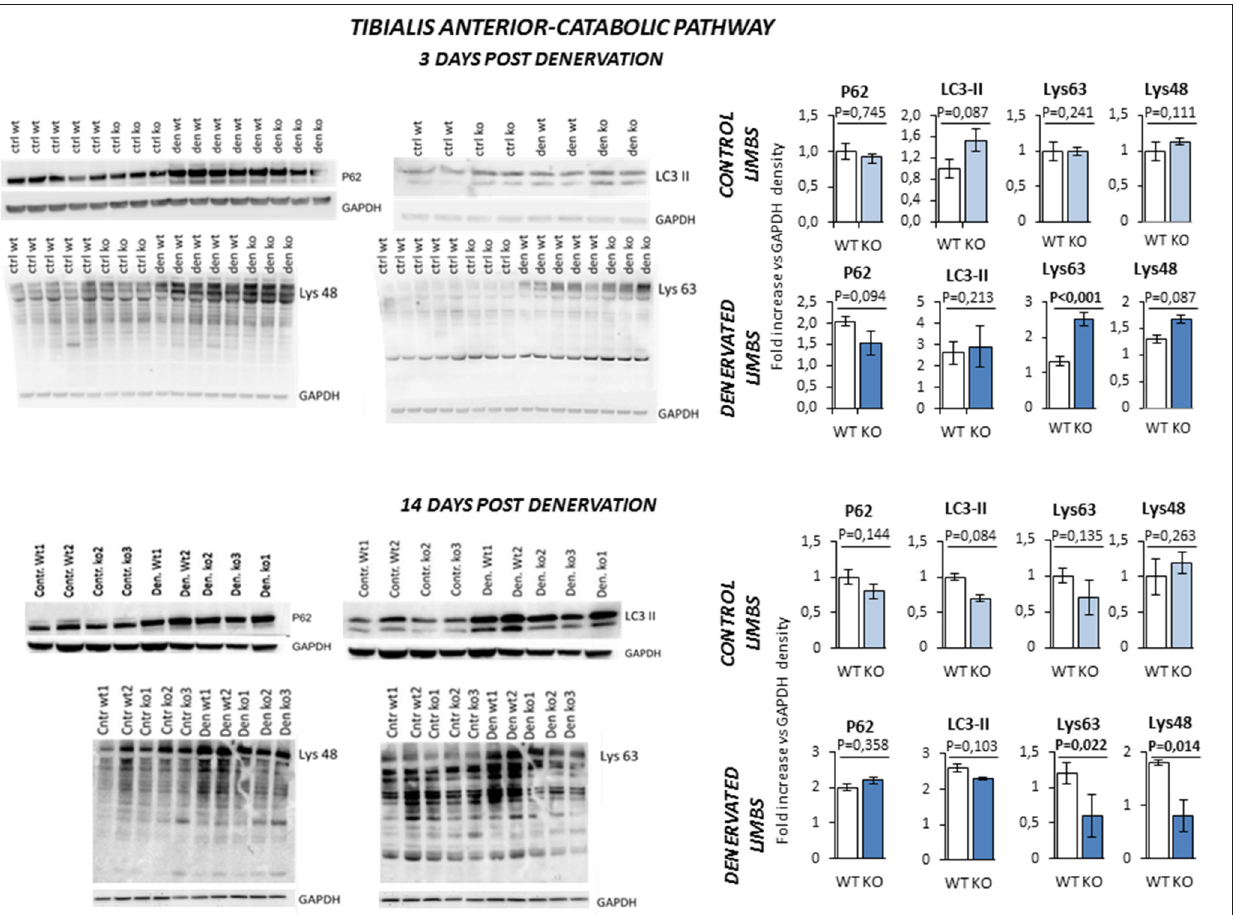
FIGURE 8 | Activation of catabolic pathway in tibialis anterior muscle specimens obtained from contralateral non-denervated (CONTROL) and denervated (DENERVATED) limbs in wild type (WT) and Rxfp2 − / − mice (KO), at both 3 (WT, N = 5; KO, N = 4) and 14 (WT, N = 6; KO, N = 5) days post-denervation. LC3-II and P62, markers of cell autophagy, and Lys-48 and Lys-63 poly-ubiquitination (poly-U), markers of the activation of the proteasome system, were monitored by western blot analysis, whose representative images are given. Target band densities were normalized on corresponding GAPDH as loading control. Data are reported as mean values ± standard error of the mean. Significance: P -values between compared conditions are reported. Significant differences ( P < 0.05) are highlighted in bold.